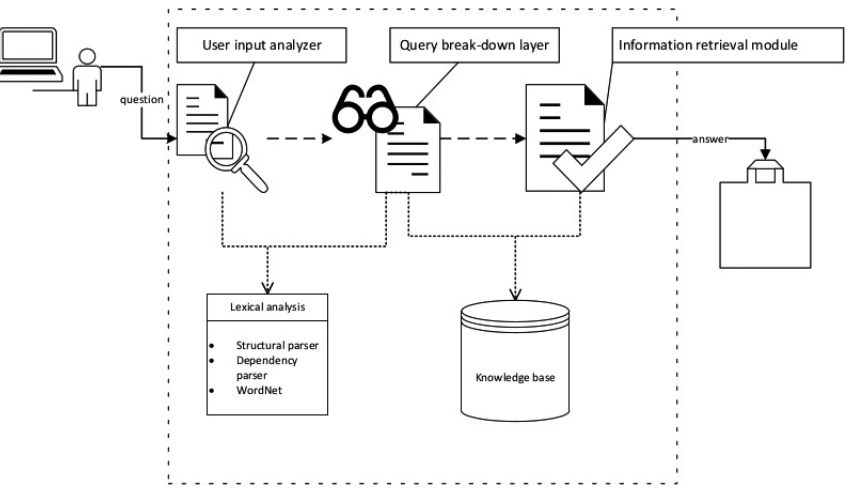
Fig. 1. Query answering